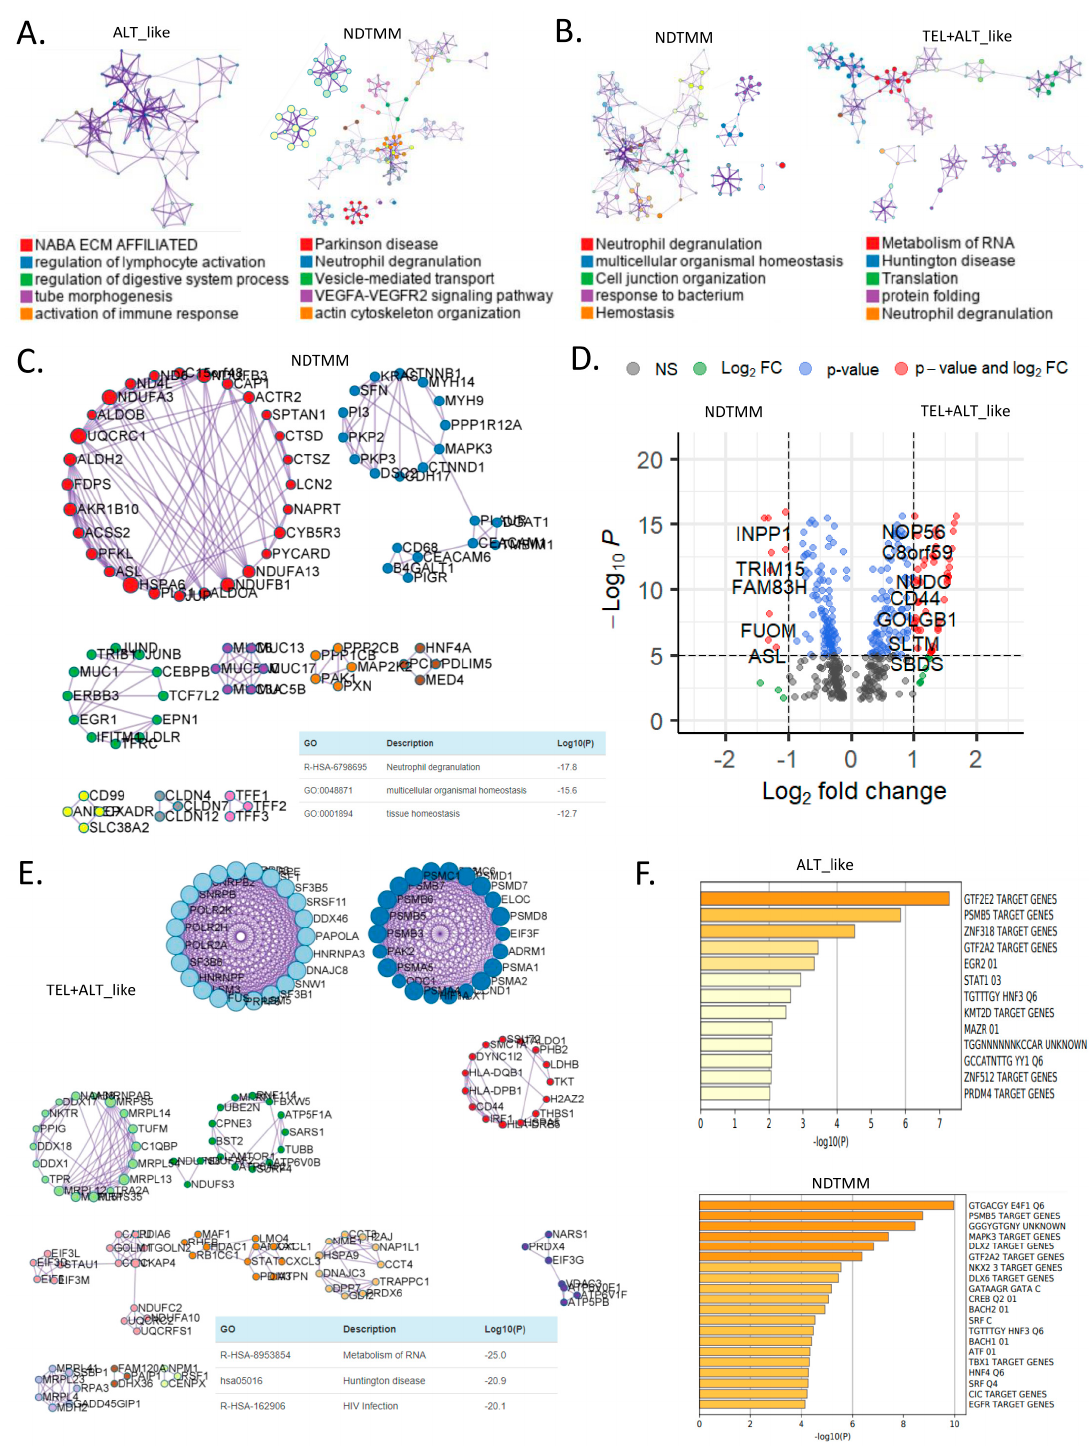
Figure 3. Biological pathways related to differentially expressed genes (DEGs) of different telom- ere maintenance mechanism (TMM) types in adenocarcinoma. Enriched biological network for ( A ) ALT-like (left) and NDTMM (right) and ( B ) NDTMM (left) and TEL+ALT-like (right) types of ade- nocarcinoma. ( C ) PPI network of nine clusters for NDTMM type analyzed using MCODE algorithm. ( D ) Volcano plot of DEGs between NDTMM and TEL+ALT-like types of adenocarcinoma. ( E ) PPI network of 12 clusters of TEL+ALT-like type cells analyzed using MCODE. ( F ) Bar graph of TF for ALT-like and NDTMM